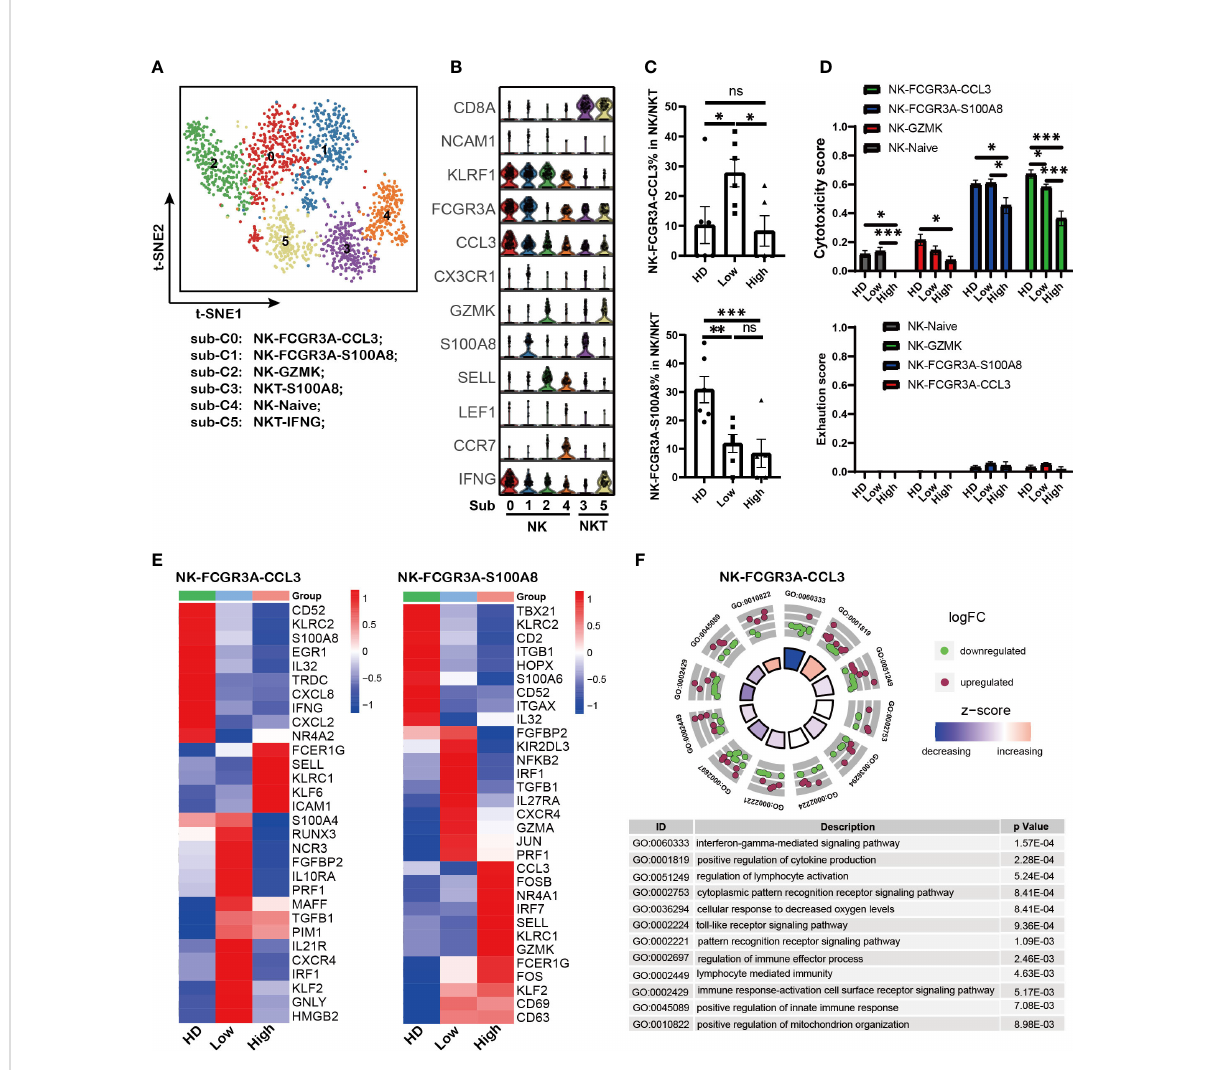
FIGURE 4 PIM1 , KLRC1 and abnormal metabolism processes were involved in defective NK cells induced by high tumor burden (A) . t-SNE shows the NK cell sub-clusters from HD and MM patients. Cells with high expression of PTPRC and KLRF1 were selected as NK/NKT cells. Each dot represents a single cell; colors indicate cell clusters with numbered labels. (B) .Violin plots show the expression and distribution of classical cell markers of NK sub-clusters. The sub-cluster numbers in the graph bottom correspond to the ones in (A). Sub-C0: NK-FCGR3A-CCL3; sub-C1: NK-FCGR3A-S100A8; sub-C2; NK-GZMK; sub-C3: NKT-S100A8; sub-C4: NK-NAÏVE; sub-C5; NKT-IFNG-CX3CR1 (C) . Bar charts show the proportion of NK cell sub-clusters from HD and MM patients in different in fi ltration groups (HD: n=7; Low: n=6; High: n=6). (D) . Bar charts show the cytotoxicity scores and exhaustion scores of NK cell sub-clusters from HD and MM patients in different in fi ltration groups (HD: n=7; Low: n=6; High: n=6). (E) . Heatmaps shows the DEGs of NK-FCGR3A-CCL3 and NK-S100A8 among HD and MM patients in different in fi ltration groups. (F) . GO Enrichment of DEGs in NK-FCGR3A-CCL3 between MM patients with high tumor burden and low tumor burden. Each dot in the graphs represents a single gene from DEGs. Upregulated genes are indicated as red dots and downregulated genes are indicated as blue dots. The color bar indicates the z-score of each pathway. In all instances, p < 0.05 was considered signi fi cant, * p < 0.05, ** p < 0.01 and *** p < 0.001. ns, no signi fi